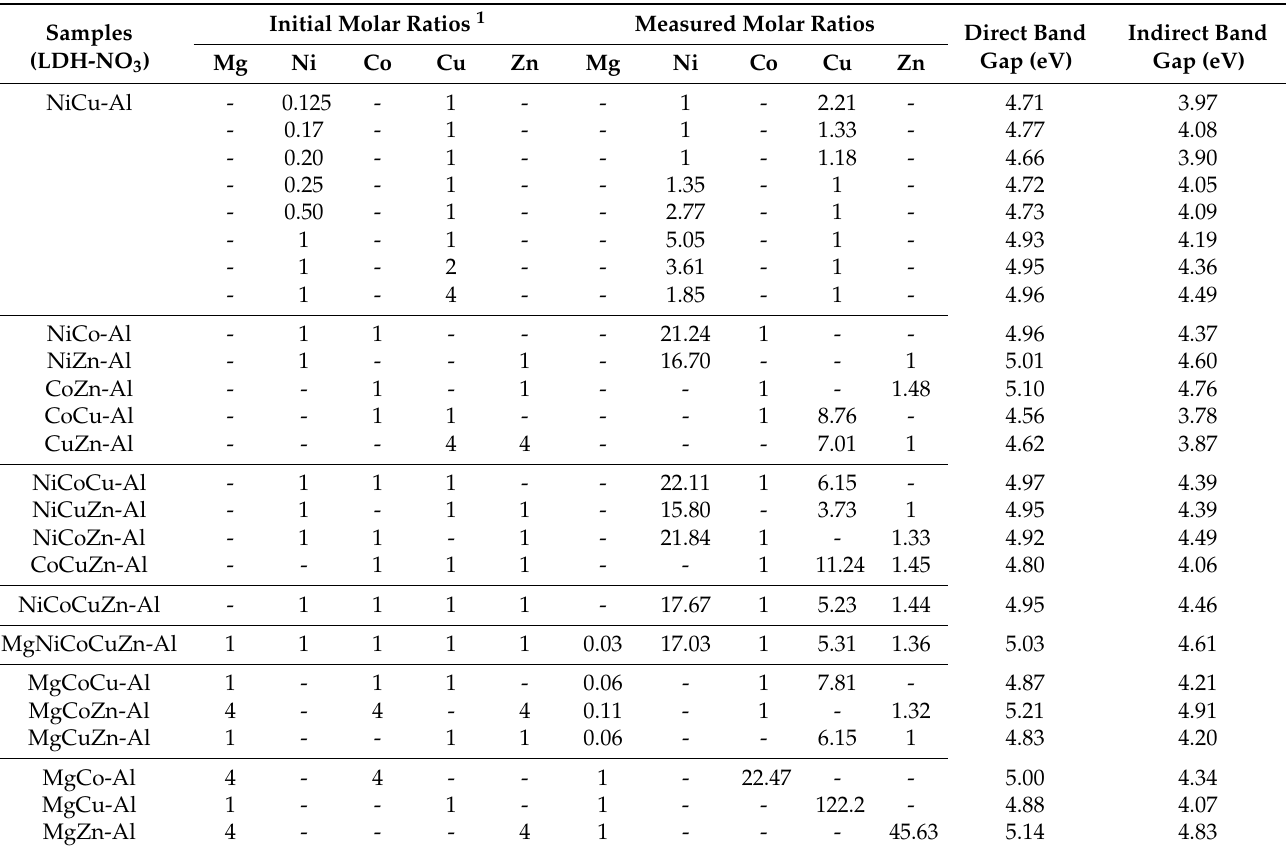
Table 1. The molar ratios of the incorporated metal ions into the gibbsite structure; the initial and the measured values in the formed LTHs/LMHs, and their direct and indirect optical band gap